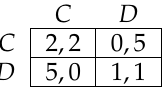
Figure 2. Prisoner’s